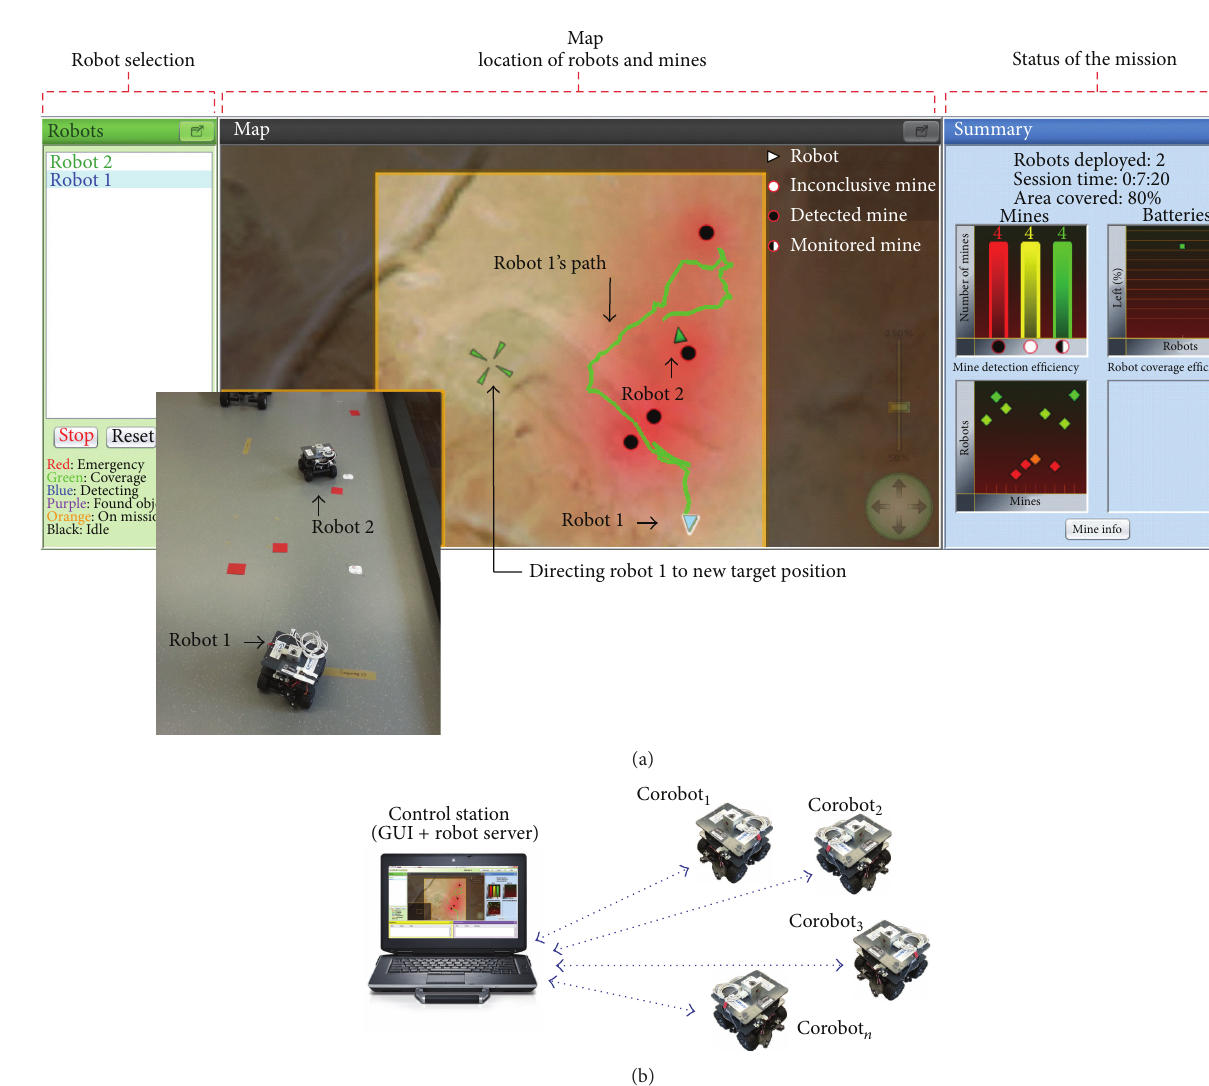
Figure 5: (a) Snapshot of the COMRADES graphical user interface. The image illustrates a panorama of the experimental environment using two Corobot robots. After 5 minutes of exploration the robots have detected 4 landmines shown by red circles. The path followed by the robots is shown by the green trail. (b) Communication architecture of the COMRADE system. Dotted lines indicate wireless communication via Wi-Fi between the robots and the robot server at the control